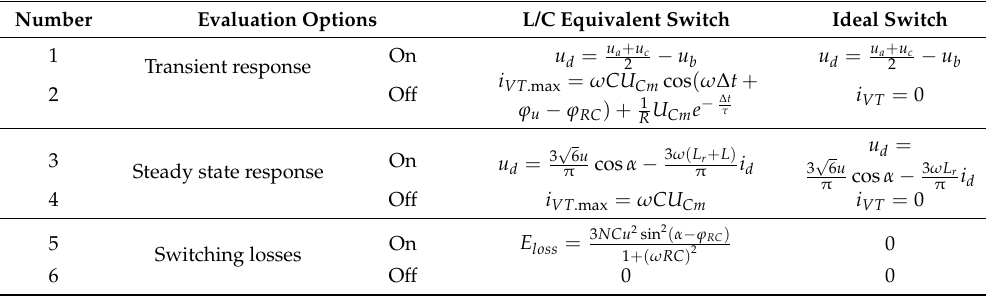
Table 3. The difference between the L/C equivalent switch and the ideal switch.